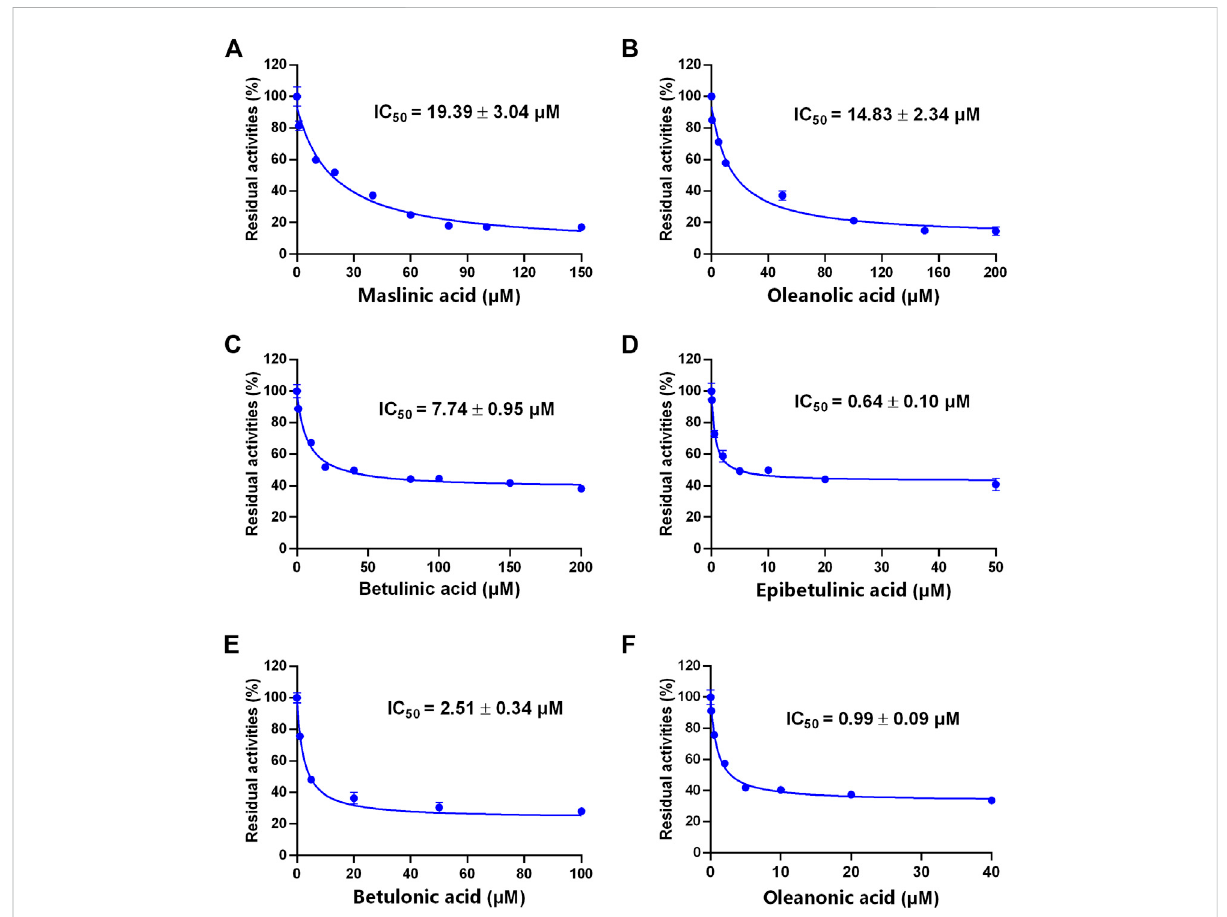
FIGURE 5 Theinhibitoryeffectsofthepentacyclictriterpenoidacids(maslinicacid (A) ,oleanolicacid (B) ,betulinicacid (C) ,epibetulinicacid (D)